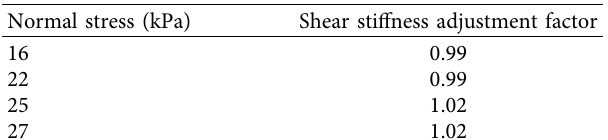
Table 6: Adjustment coefficient of shear stiffness under different normal stress.